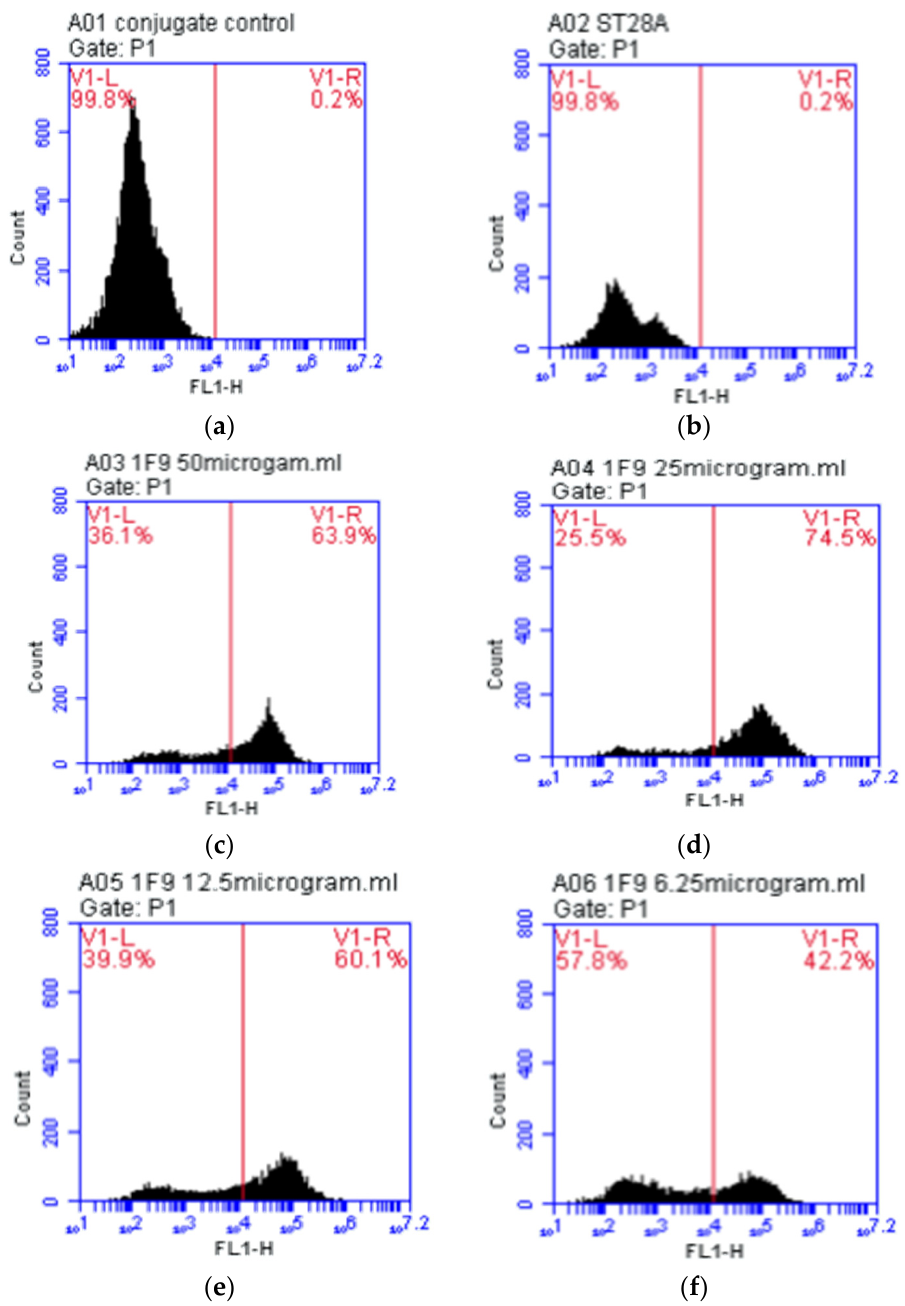
Figure 6. The relationship between the fluorescence concentration (FL1-H) and the number of cells (Count) ( a ) the control sample ( b ) the control sample ST28A ( c ) The sample A03 ( d ) The sample A04 ( e ) The sample A05 and ( f ) The sample A06 areas of 1F9 monoclonal antibody at various concentra- tions.